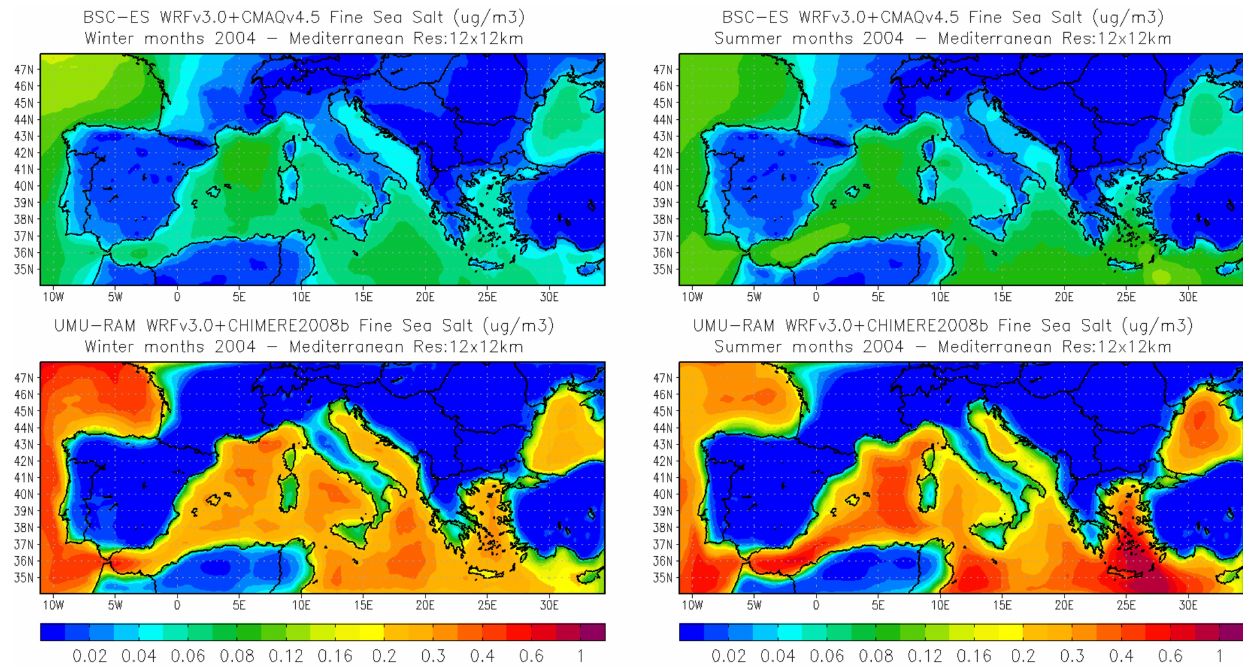
Fig. 5. (Left) modeled winter (DJF) mean fine SSA concentration (PM 2 . 5 ) (µgm − 3 ) for WRF + CMAQ (top) and WRF + CHIMERE Fig. 5. (Left) Modeled winter (DJF) mean fine SSA concentration (PM2.5) ( µ g m − 3 ) for WRF+CMAQ (bottom) simulations; (right) modeled summer (JJA) mean fine SSA concentration (PM 2 . 5 ) (µgm − 3 ) WRF + CMAQ (top) and WRF + CHIMERE (bottom). (top) and WRF+CHIMERE (bottom) simulations; (Right) Modeled summer (JJA) mean fine SSA con-